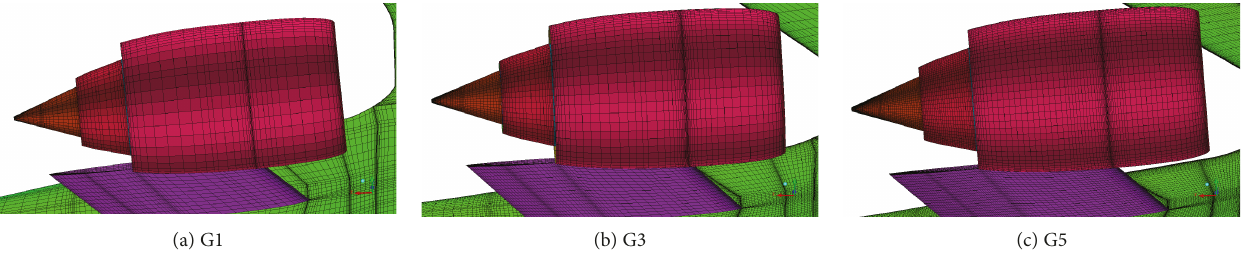
Figure 6: Closeup view of engine grids for the powered con fi guration of G1, G3, and G5.